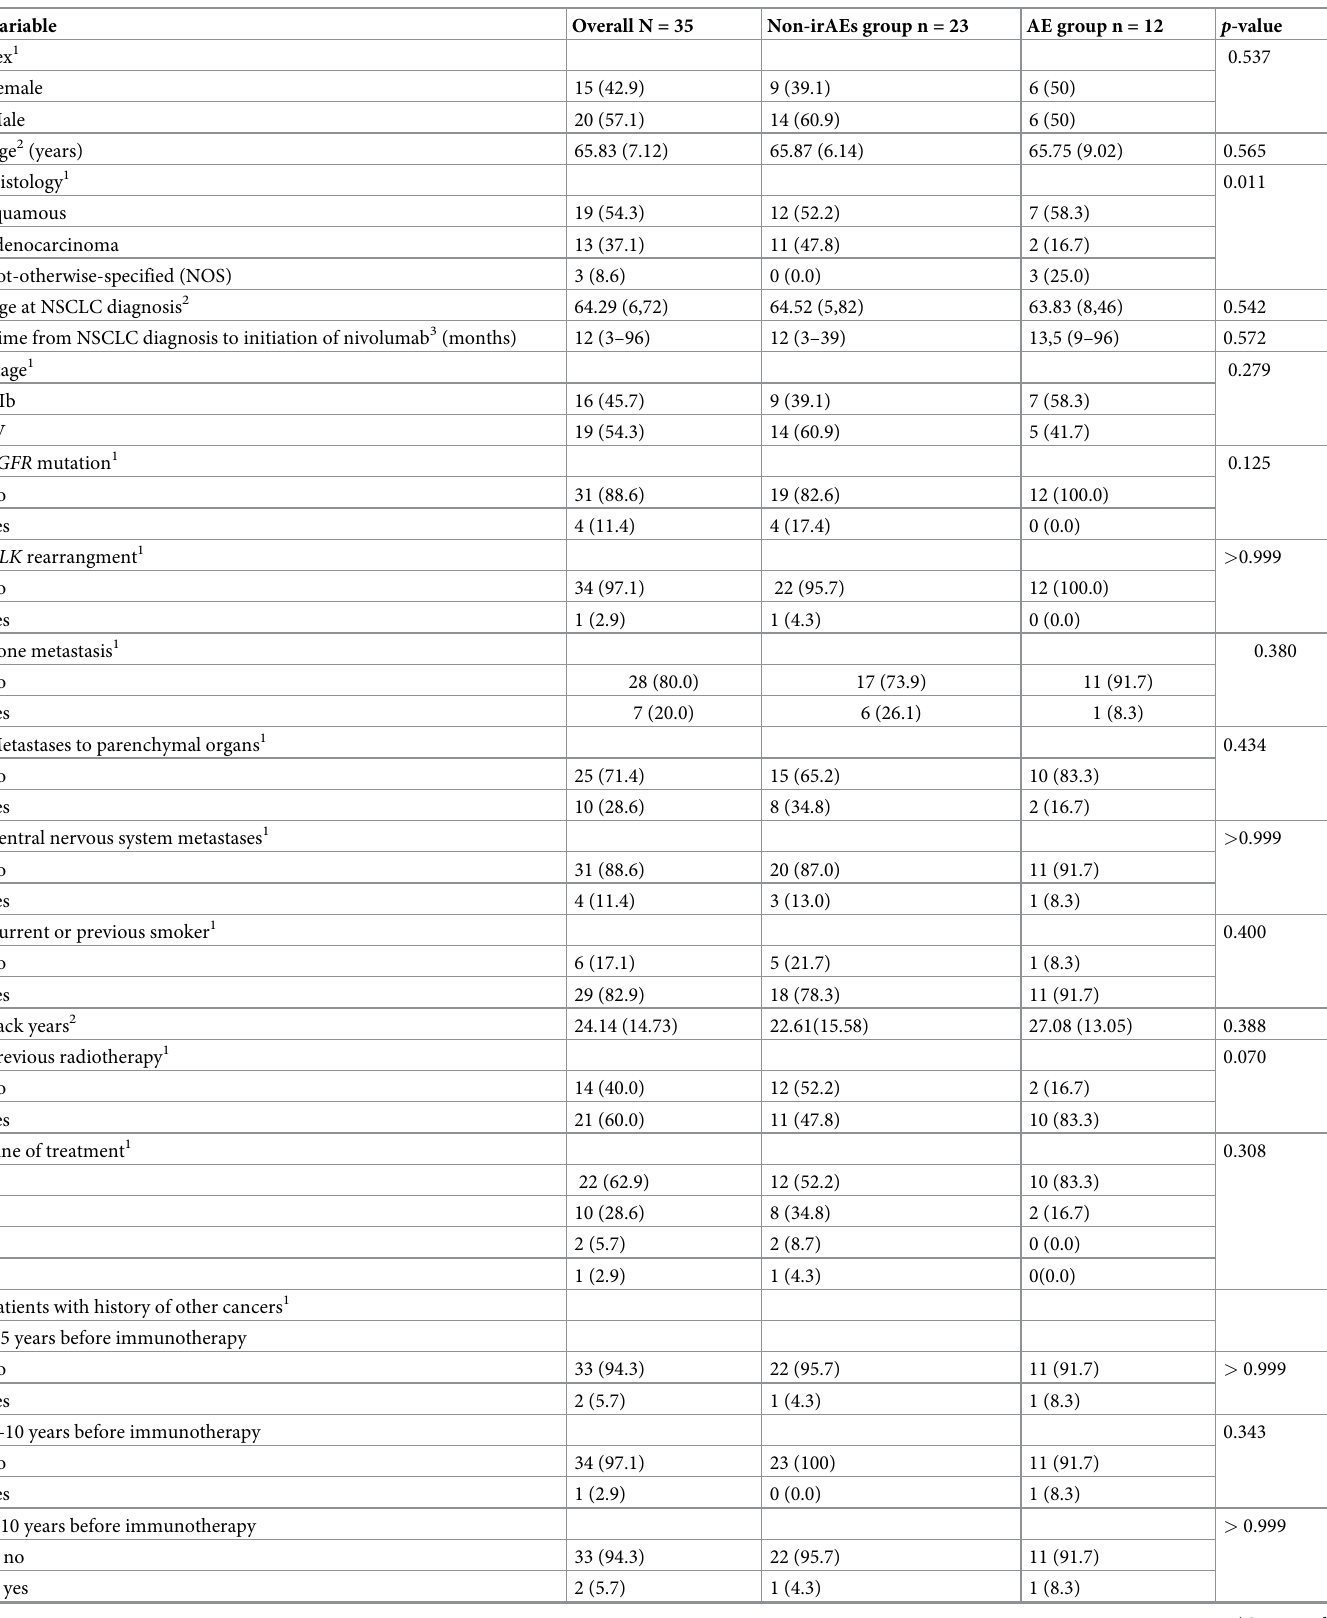
Table 1. Patients